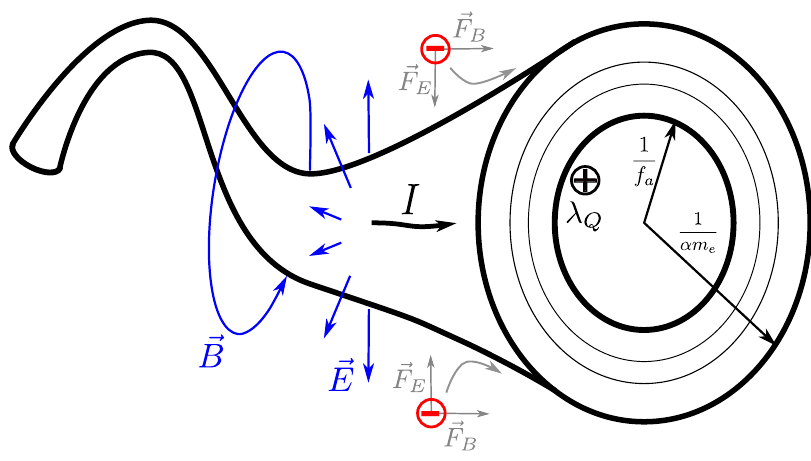
Figure 1 . A schematic figure of the cross section of the axion string. The string carries a positive charge density λ up to 10 9 GeV and a current in the direction of the black arrow. The charge Q and current on the string core create a strong electromagnetic field around the string core in the direction shown by the blue arrows. The strong electromagnetic field produces charged standard model particles and attracts the negatively charged SM particles into bound states with the string core, traveling in the same direction as the PQ fermions on the positively charged string core. The positively charged string core is surrounded by multiple layers of standard model particles from gauge bosons, pions to standard model quarks and leptons, forming a one-dimensional “atom” with radius of 1 /αm e